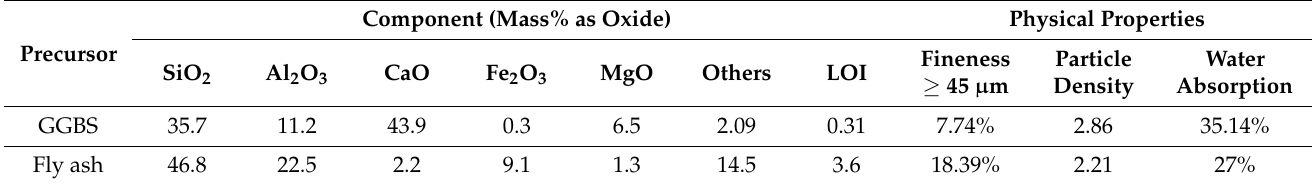
Table 1. Oxide composition and physical properties of GGBS and fly ash (Adapted from Ref. [12]).